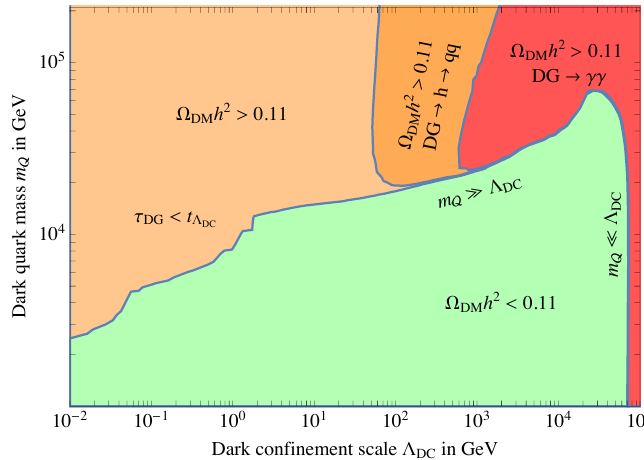
Figure 4 . Qualitative dependence of the DM relic abundance as function of (cid:3) the cosmological value is reproduced along the boundary between the green and red regions. For (cid:3) DC m Q 100 TeV we recover the results of [1]. A lighter m (cid:28) (cid:25)